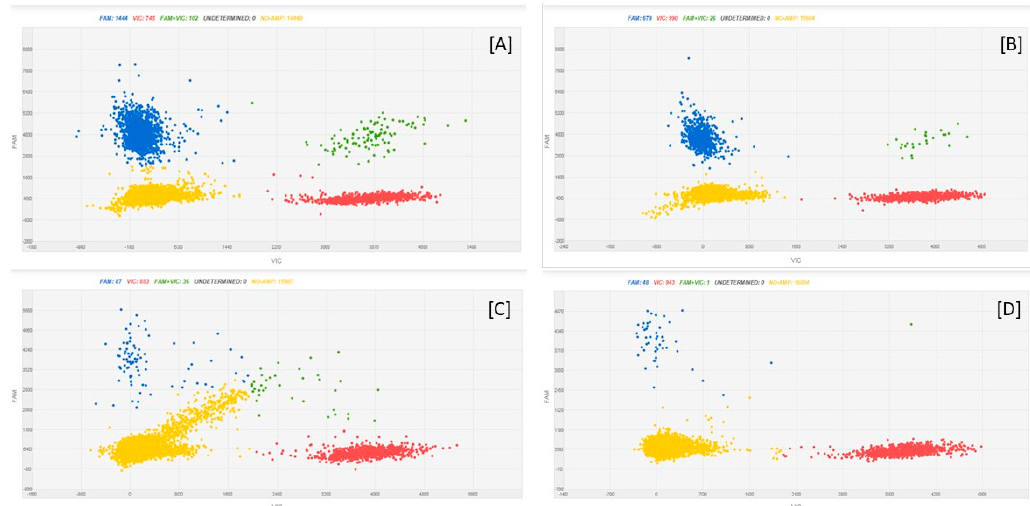
Figure 5. cdPCR amplification plots of oat DNA spiked with F. avenaceum DNA dilutions. [ A ] = 20 ng oat DNA + 0.25 ng F. avenaceum DNA; [ B ] = 20 ng oat DNA + 0.1 ng F. avenaceum DNA; [ C ] = 20 ng oat